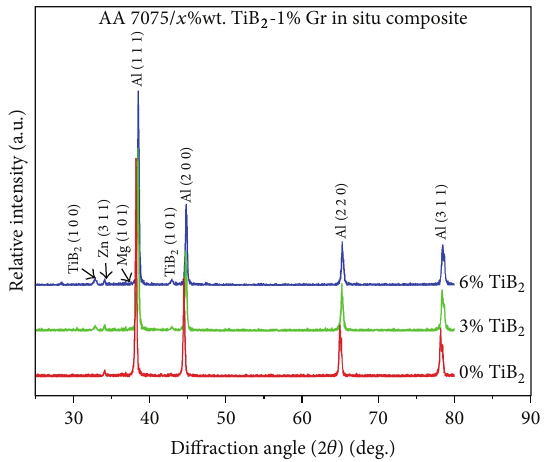
Figure 4: XRD results of Al 7075 + 𝑥 % TiB 2 + 1% Gr hybrid composites ( 𝑥 = 0, 3, and